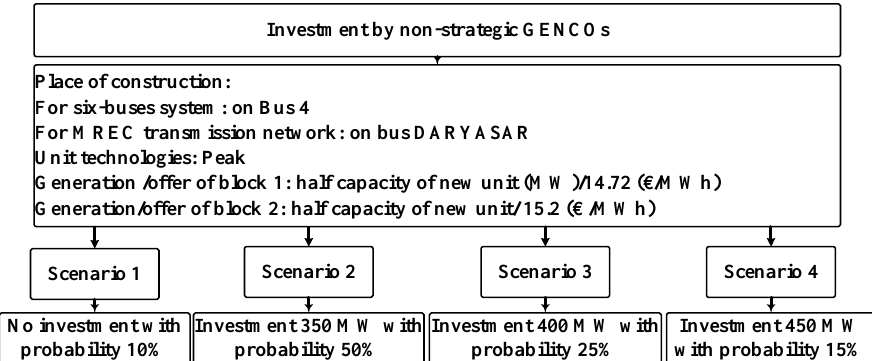
Figure 3. The emulation structure of four different basic levels scenarios proposed for investment by non-strategic GENCOs.